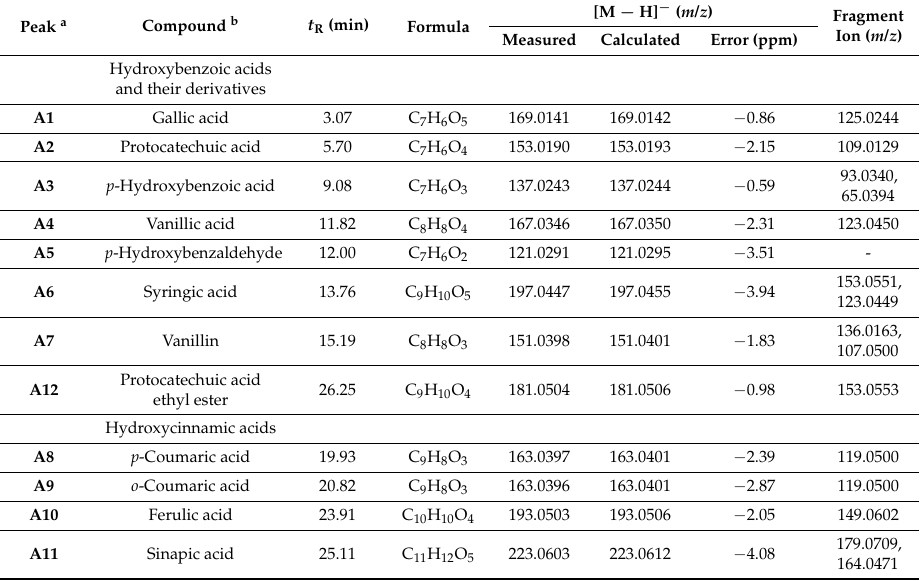
Table 2. Identification of phenolic acids and their derivatives in Fr. 1.